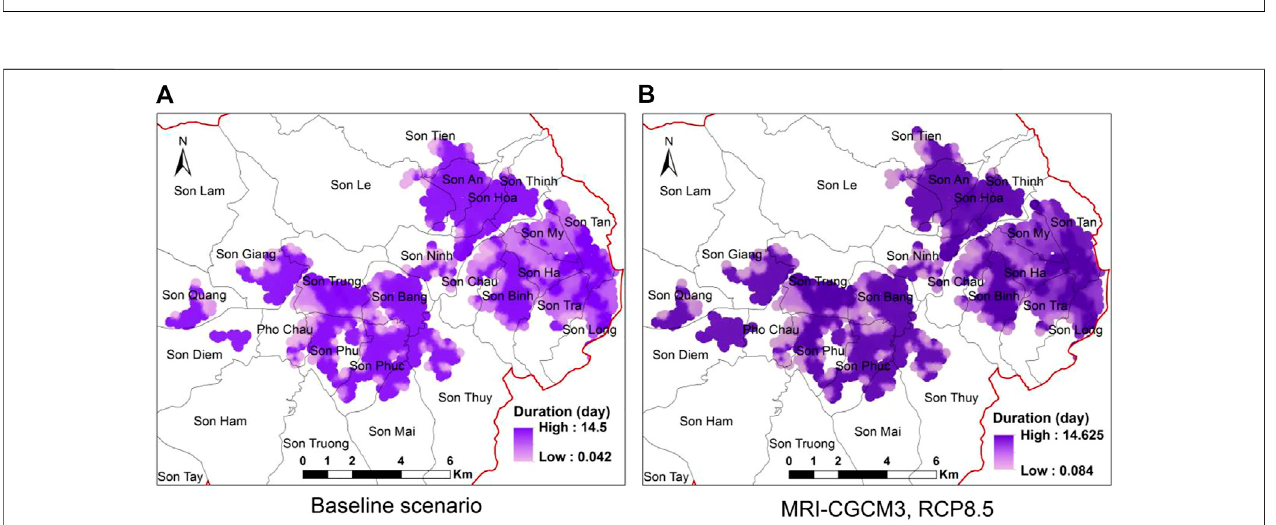
FIGURE 11 | Inundation duration under baseline and MRI-CGCM3, RCP8.5 scenarios.